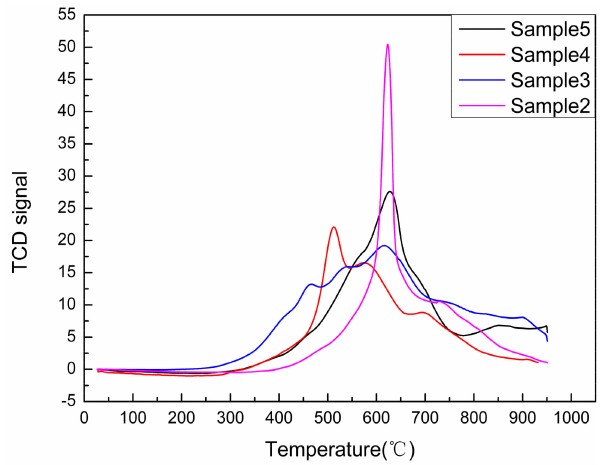
Figure 8. H 2 -TPR (temperature-programmed reduction) diagram of modified rare earth